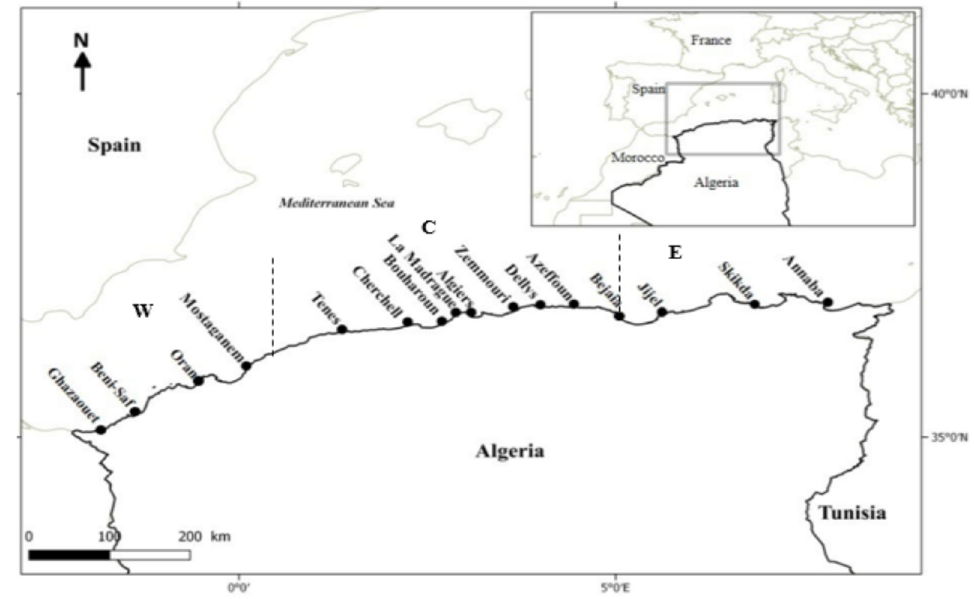
Fig. 1. Study area of P. blennoides with sampled landing ports (W: sector west, C: sector center, E: sector